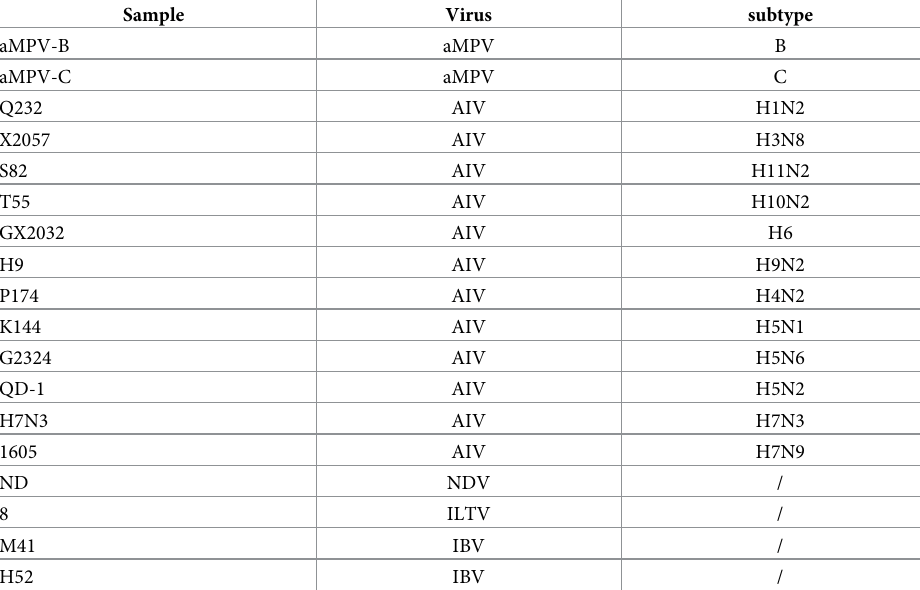
Table 2. Samples tested in the present